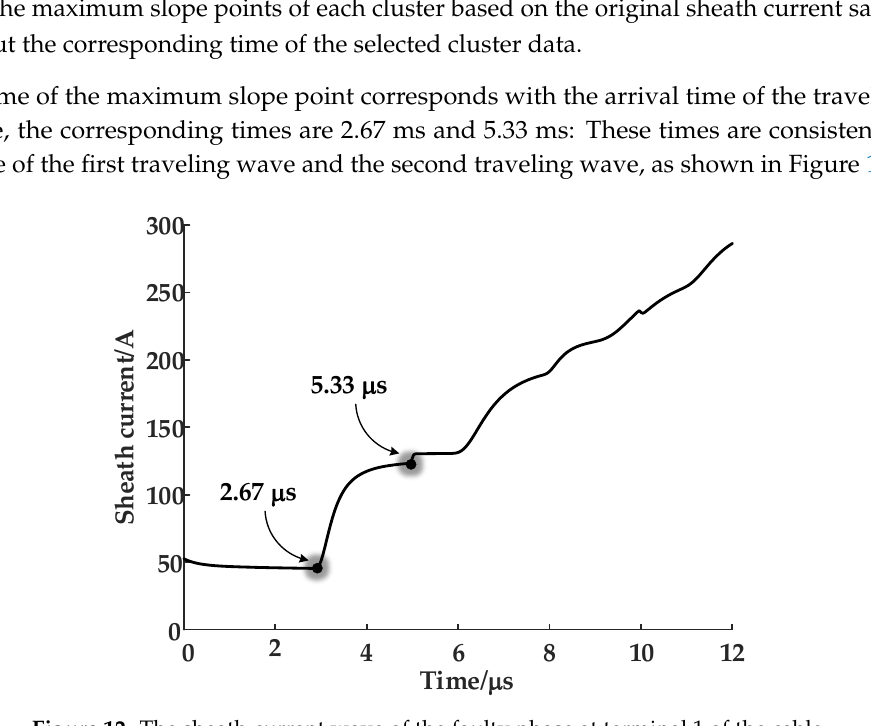
Figure 12. The sheath current wave of the faulty phase at terminal 1 of the cable.